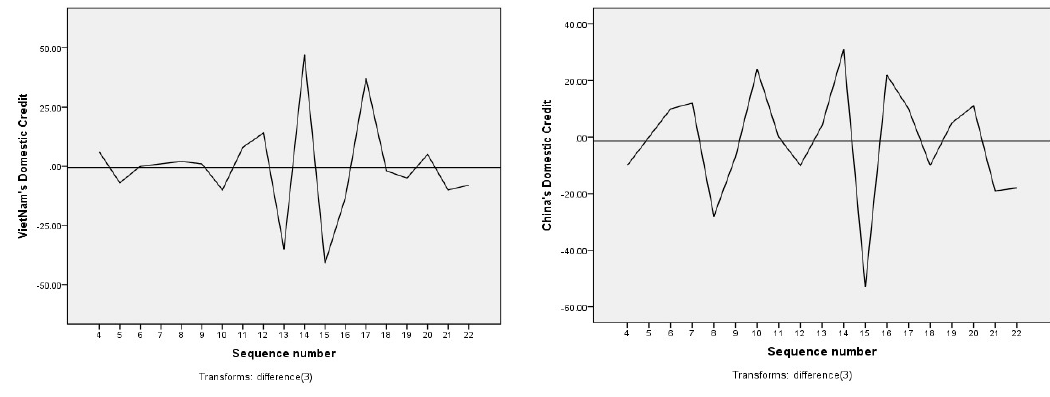
Fig. 3. Vietnam’s Domestic Credit: difference (d=3) Fig. 4. China’s Domestic Credit: difference (d=3)